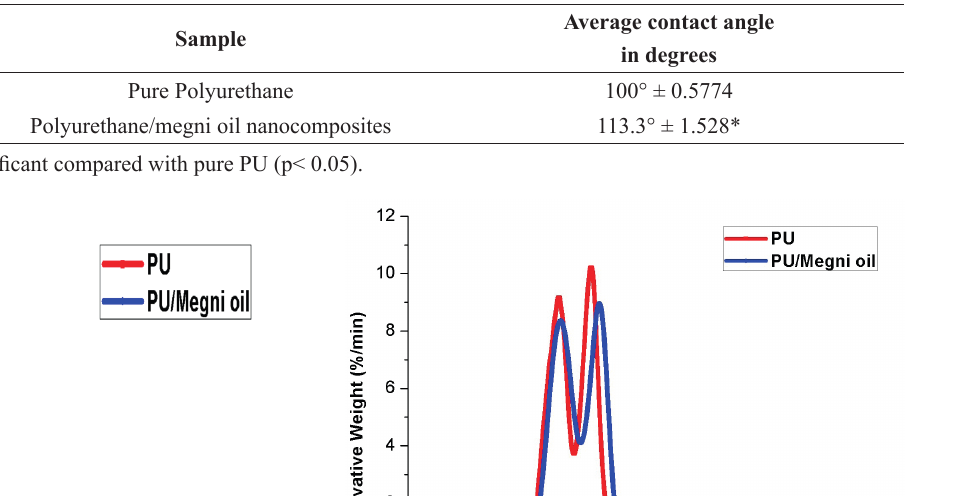
Contact angle Measurement of PU and PU/megni oil nanocomposite.